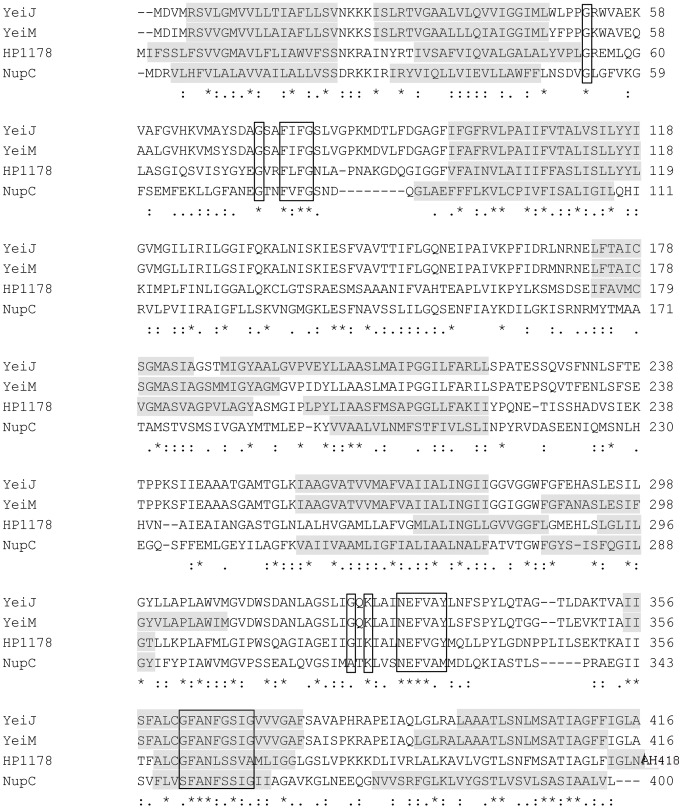
Sequence comparison between H. pylori NupC homolog (HP1180) and three E. coli CNT paralogs.Sequences for E. coli YeiJ (GenBankTM accession number AAA60513.1), E. coli YeiM (GenBankTM accession number AAA60518.1), HP1180 (GenBankTM accession number AAD08224.1), and E. coli NupC (GenBankTM accession number CAA52821.1) were aligned using ClustalW. Membrane-spanning helices were predicted using the TMHMM program [46]. Conserved regions typical of CNT transporters are boxed in black [34].